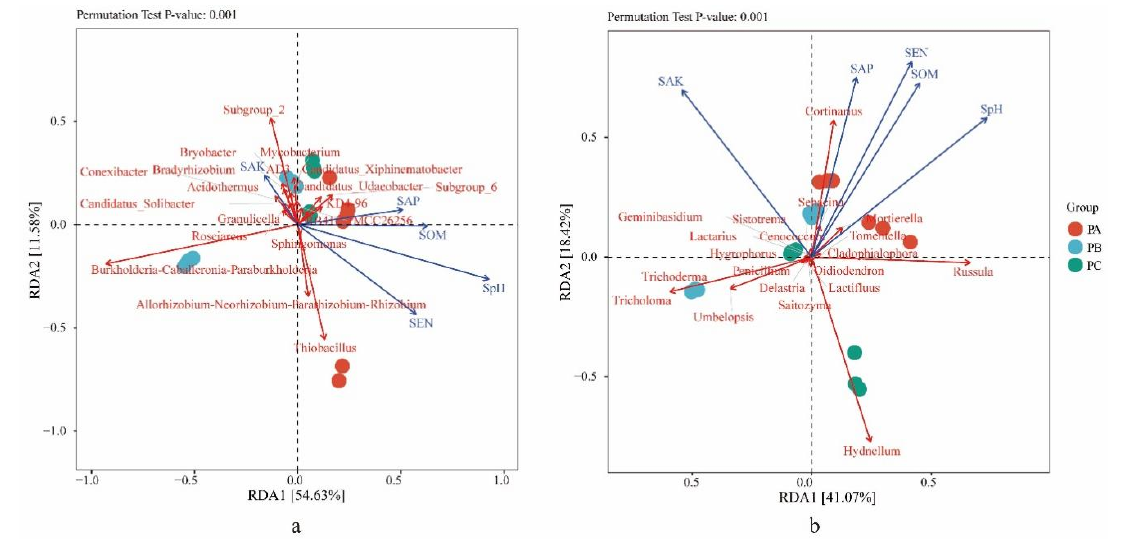
Figure 3. The relationships of soil physicochemical factors with ( a ) bacteria and ( b ) fungal communi- ties in soil with different collection sites. PA, soil samples from plot A; PB, soil samples from plot B; PC, soil samples from plot